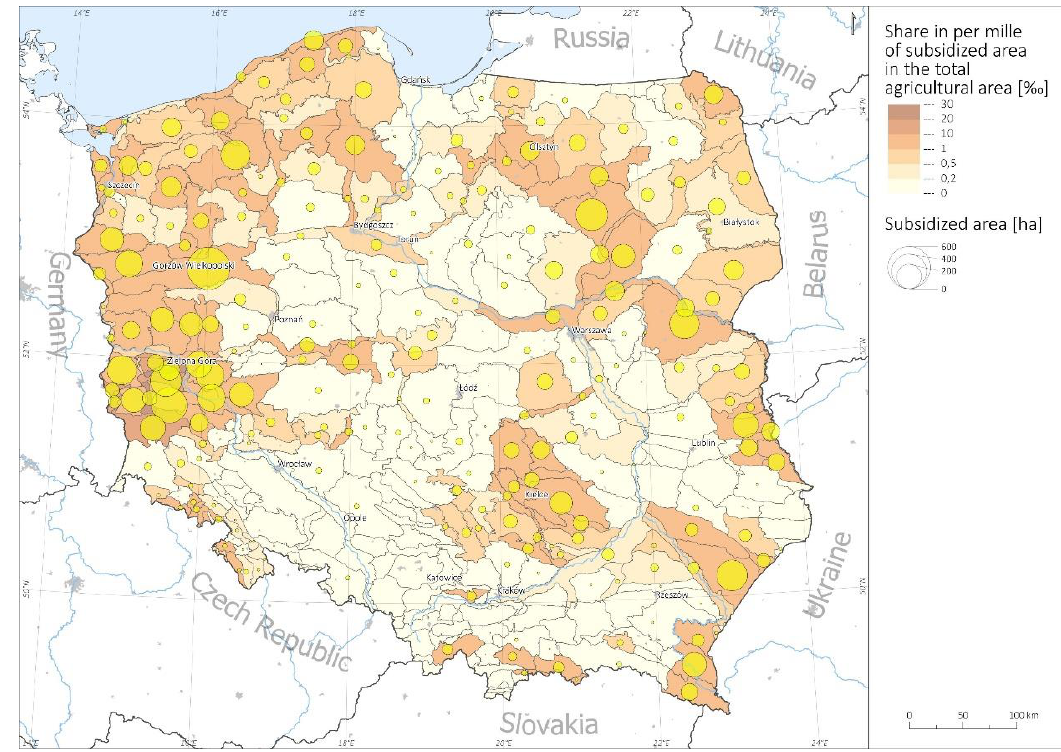
Figure 5. Area of land subsidised to support the protection of dry grasslands and their share in the total area of agricultural land in mesoregions (Source: Authors based on ARMA data).